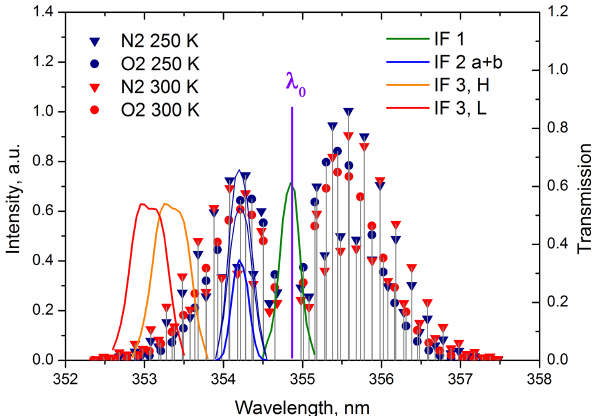
Figure 1. Rotational Raman spectrum of atmospheric nitrogen and oxygen for an excitation wavelength λ 0 of 354.83nm and for two temperatures (250 and 300K). Transmission curves of the interfer- ence filters are shown for comparison. Although the Stokes lines ( λ>λ 0 ) are more intense, anti-Stokes lines ( λ<λ 0 ) are used by us to avoid possible measurement errors due to fluorescence (Immler et al. 2005). For IF3, the filter positions for both the low- and high- background settings are shown (L and H, respectively).